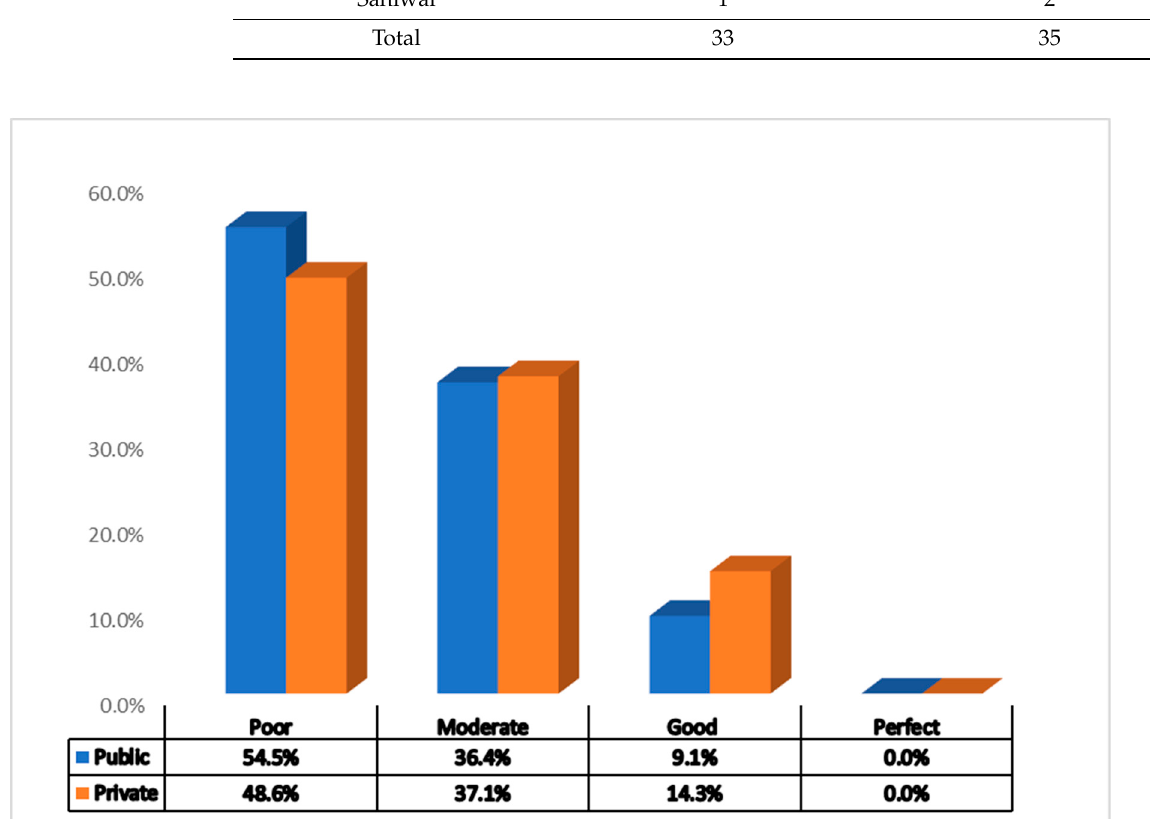
Figure 1. Percentage of public and private tertiary care hospitals in each defined category of adherence for core elements.